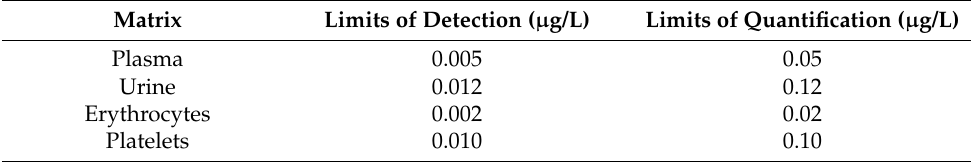
Table 3. Limits of detection and limits of quantification for